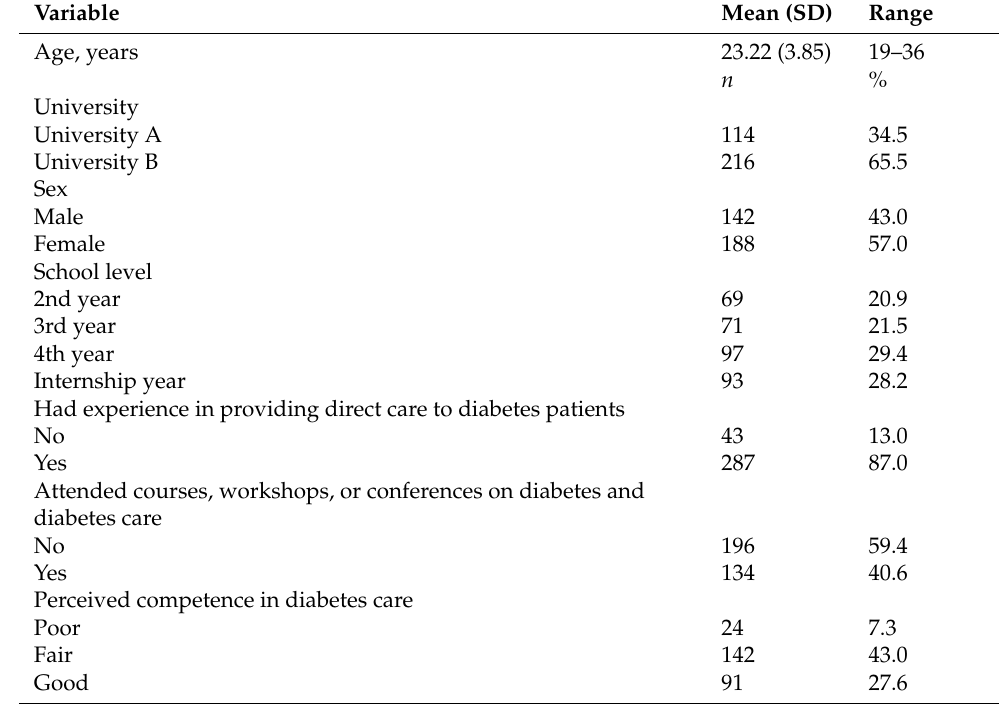
Table 1. Demographic data of the respondents ( n =